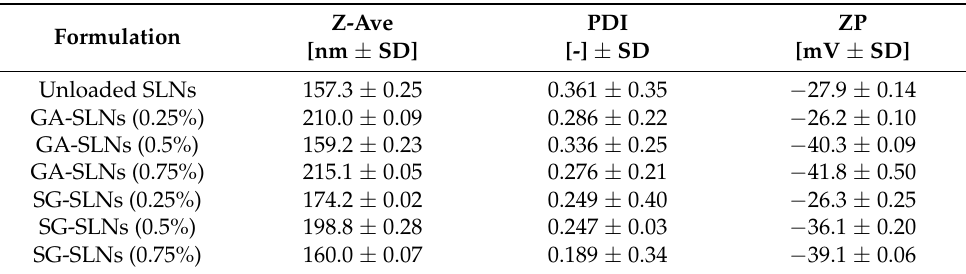
Table 1. Z-Ave, PDI, and ZP values for unloaded SLNs, GA-SLNs, and SG-SLNs at different concentrations (0.25, 0.5, and 0.75% w/v ). Formulation